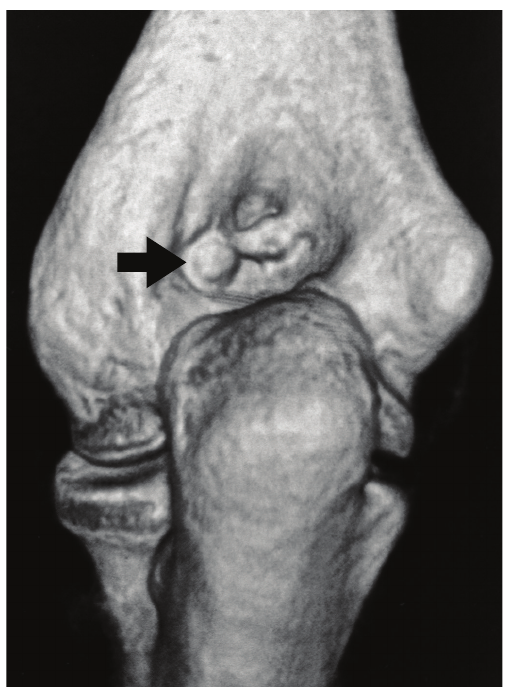
Figure 3: CT image reconstruction of the elbow: protrusion of a nidus in the lateral side of the olecranon fossa.